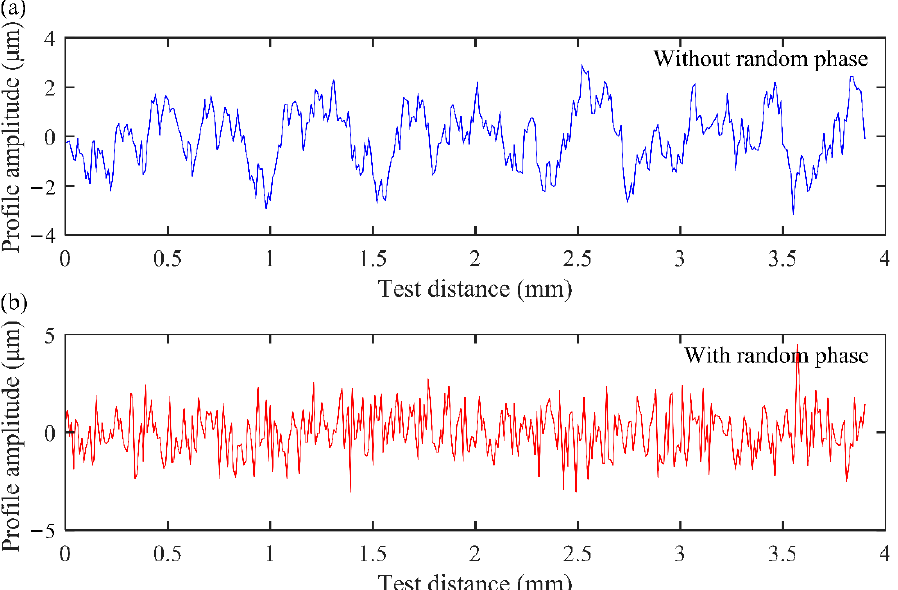
Figure 3. Topography of gear surface based on W-M fractal function: ( a ) without random phase; ( b ) with random phase.